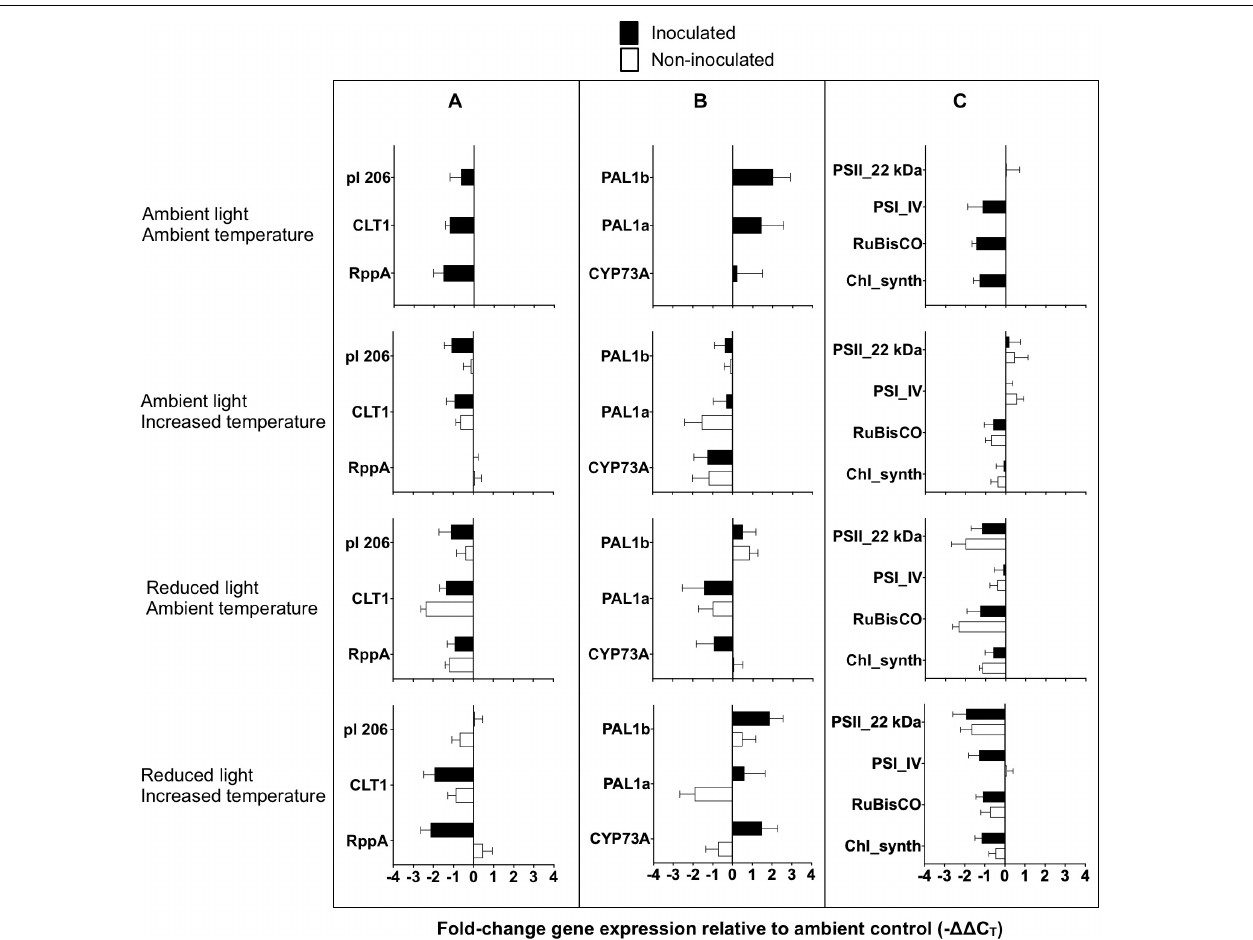
FIGURE 6 | Gene expression of Zostera marina following experimental inoculation with Labyrinthula zosterae under different treatment conditions. Mean fold-change expression relative to ambient control (– (cid:49)(cid:49) C T ) for individual genes associated with (A) immune defense, (B) phenol synthesis, and (C) primary metabolism. Ambient control referes to undamaged, non-inoculated shoots at ambient conditions of light and temperature. Gene names are abbreviated, for full gene names see Table 1 . Error bars show standard error, n =